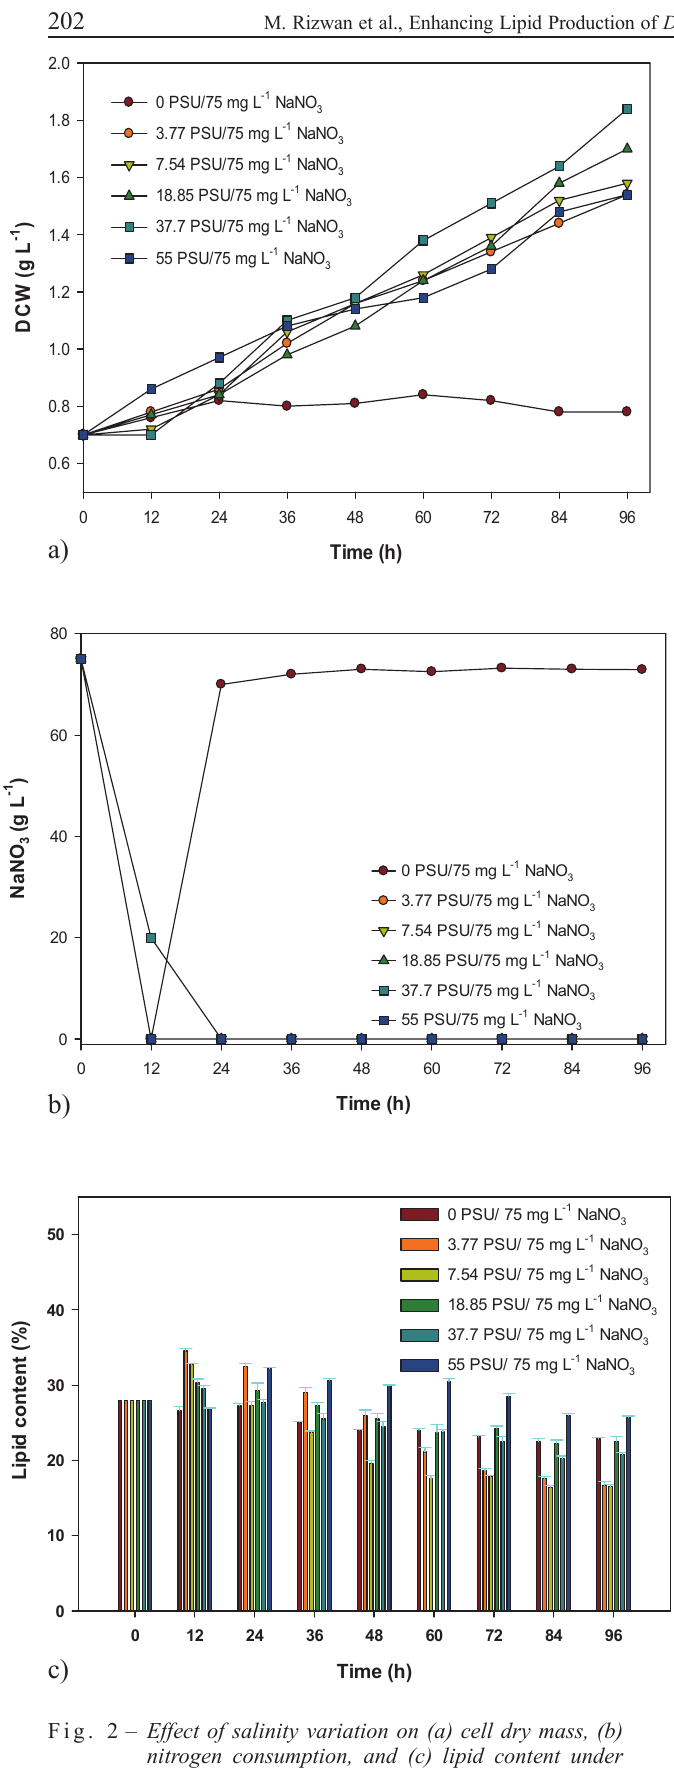
Fig. 2 – Effect of salinity variation on (a) cell dry mass, (b) nitrogen consumption, and (c) lipid content